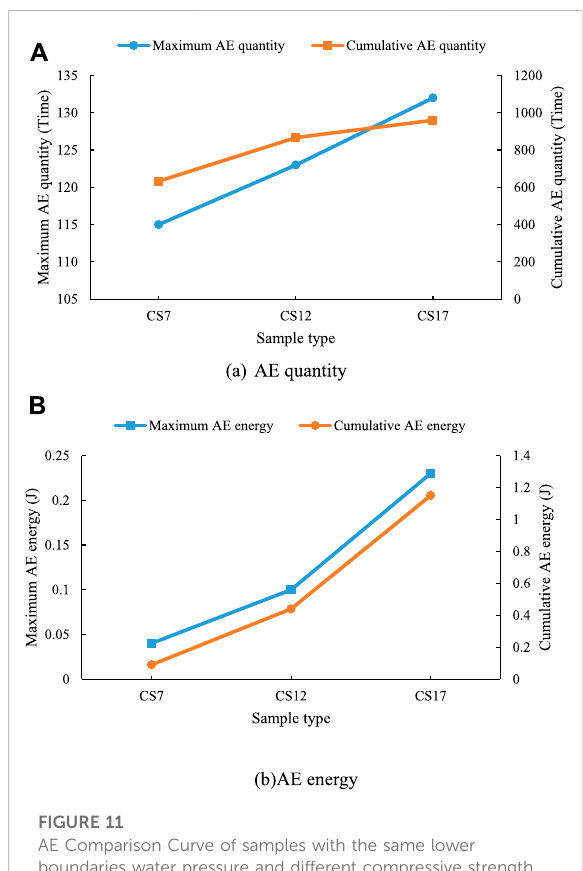
FIGURE 11 AE Comparison Curve of samples with the same lower boundaries water pressure and different compressive